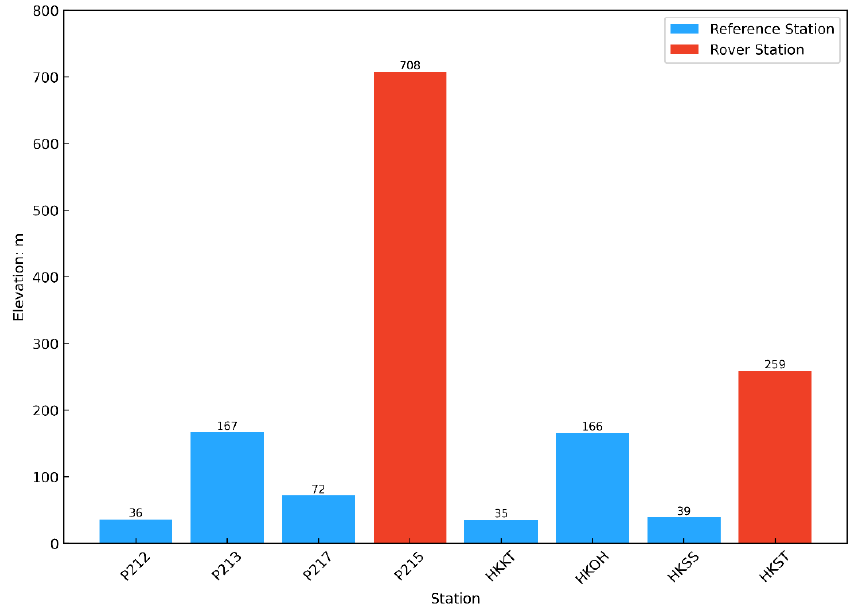
Figure 3. The elevation distribution of the stations in two datasets.